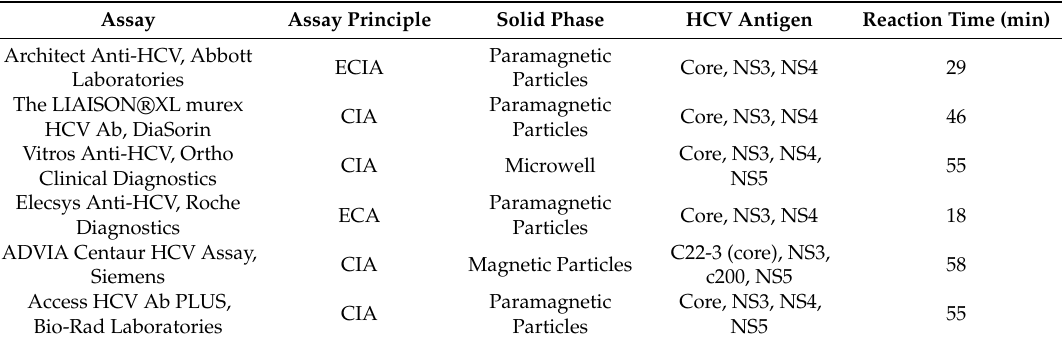
Table 3. Characteristics of automated anti-HCV antibody assays approved for in vitro